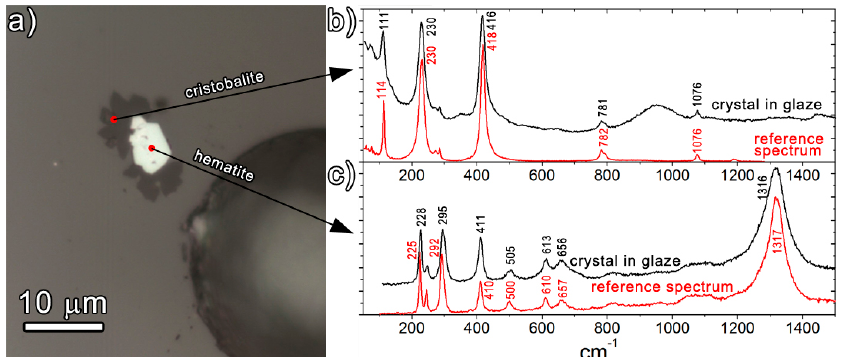
Figure 7. The Raman spectra of cristobalite and hematite: Minerals from the “Systematic Collection of Minerals” of the University of Barcelona (UB, Spain) were used as reference patterns for the Raman study. ( a ) A photomicrograph of cristobalite (lower reflectance) and hematite (higher reflectance) crystallites in a ceramic glaze (RL); the image has been acquired by using a camera coupled to the Raman spectrometer. ( b ) The Raman spectra acquired on a crystallite of cristobalite. ( c ) The Raman spectra acquired on a crystallite of hematite.